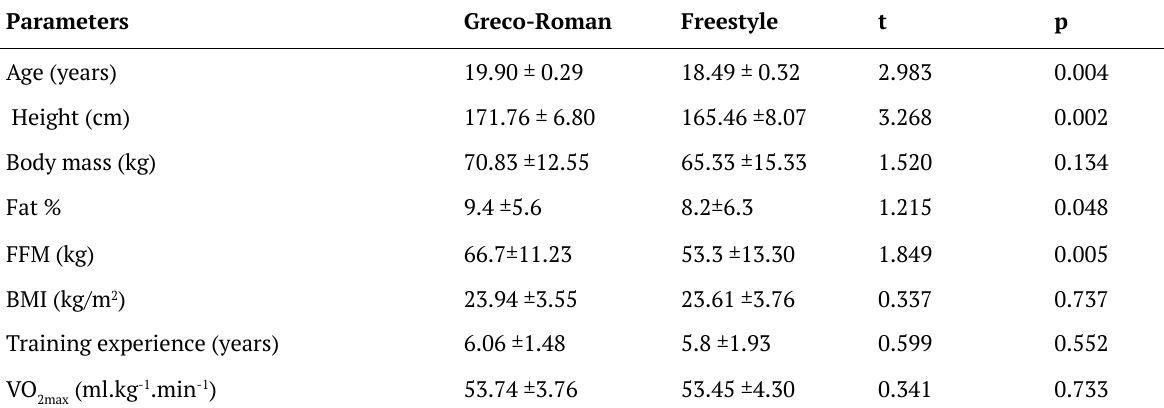
Table 1. Descriptive characteristics of Freestyle and Greco-Roman